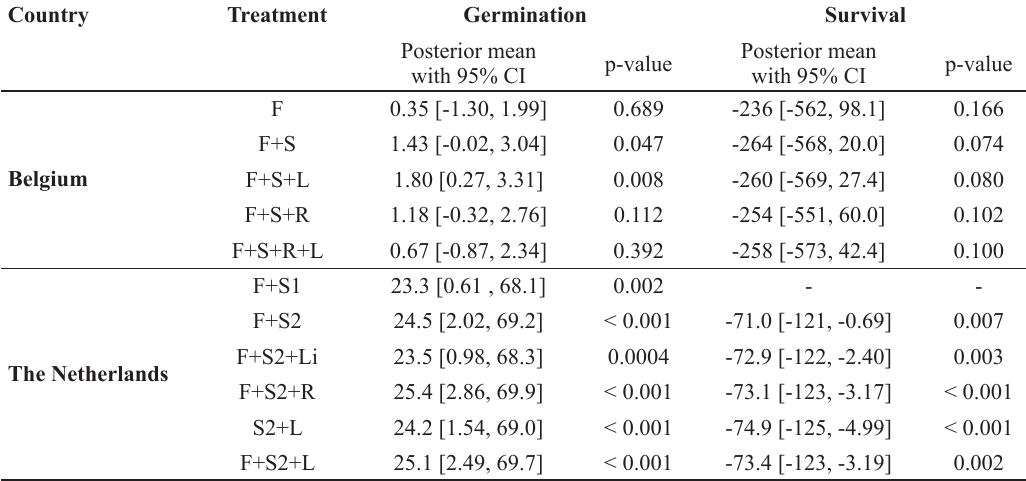
Table 3 – Germination and survival rates in the different experimental treatments, compared to the control plots. Because no seeds germinated in the control treatments (F) in the Netherlands, F+S1 was used as control comparison for survival. The number of replicate plots was n = 48 in Belgium (and n = 4 × 48 = 192 subplots) and n = 56 in the Netherlands. n.s.: not significant. F: fencing; S: deep sod cutting in Belgium; S1: shallow sod cutting in the Netherlands; S2: deep sod cutting in the Netherlands; L: liming; R: rotavation; Li: addition of